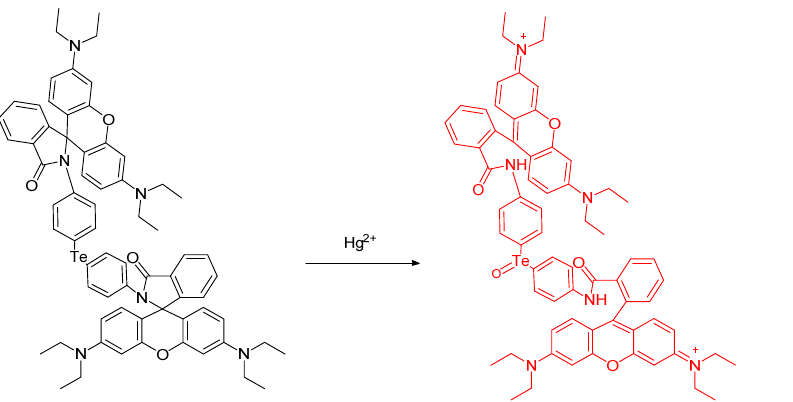
Figure 29. A tellurium–rhodamine B (TRB)–based probe that was studied for Hg 2+ detection by Soares–Paulino et al.